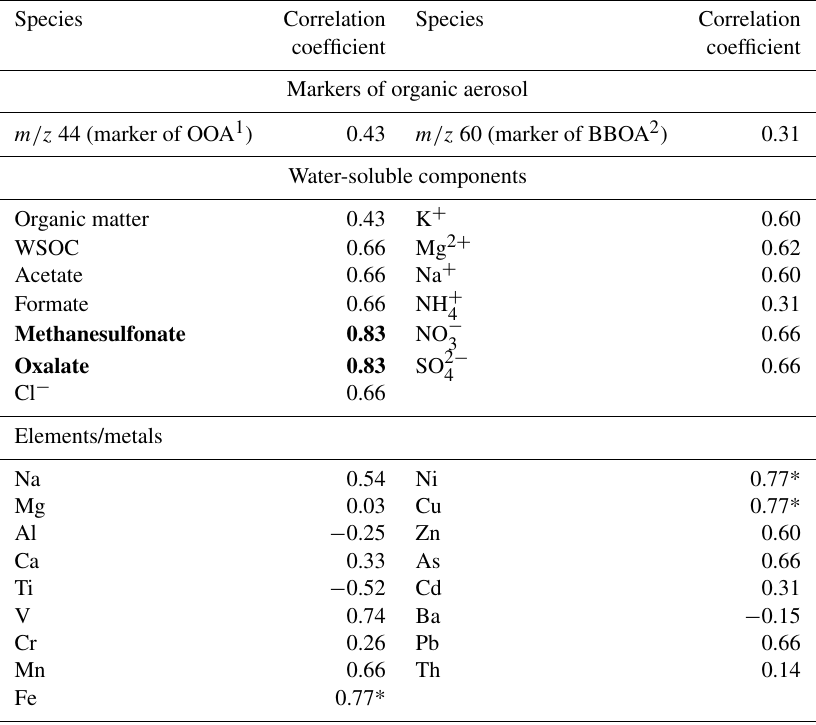
Table 2. Spearman rank correlation coefficients between concentrations of the metals/elements, markers of organic aerosol, and water-soluble (WS) components in the aerosol samples and the corresponding ROS levels. Statistically significant ( P< 0 . 05) correlation coefficients are highlighted in bold.